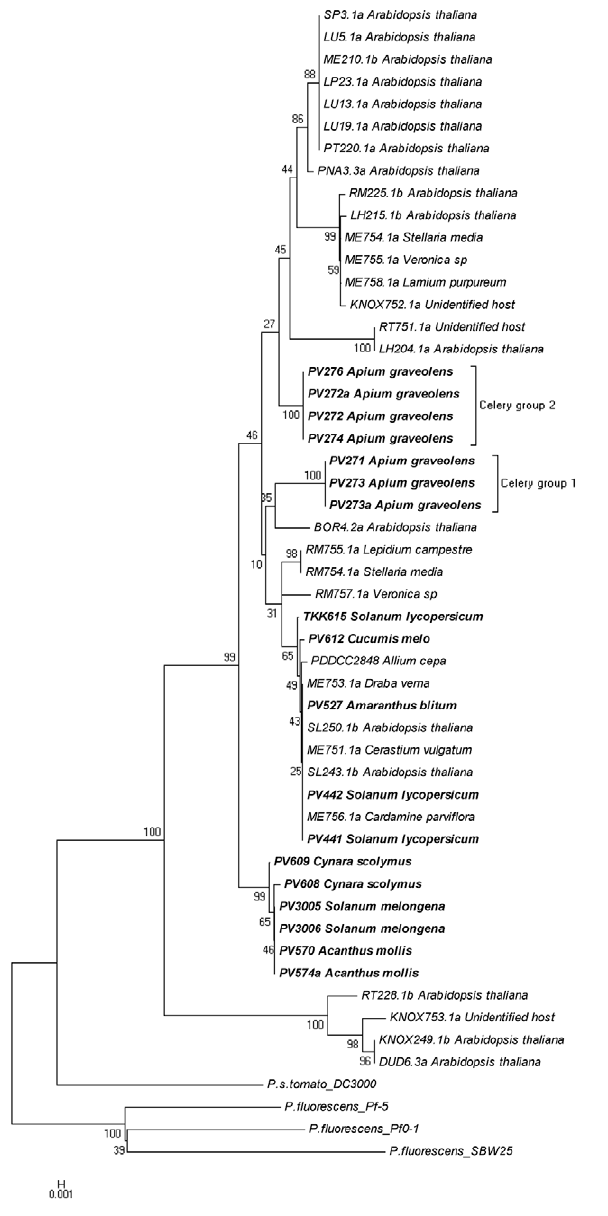
Figure 3. P.viridiflava phylogenetic tree, utilizing gyrB sequenc- es determined in this study along with sequences obtained from GenBank. The evolutionary history was inferred using the Neighbor-Joining method. The bootstrap consensus tree inferred from 1500 replicates is taken to represent the evolutionary history of the taxa analyzed. Branches corresponding to partitions reproduced in less than 50% bootstrap replicates are collapsed. The percentage of replicate trees in which the associated taxa clustered together in the bootstrap test are shown next to the branches. The tree is drawn to scale, with branch lengths in the same units as those of the evolutionary distances used to infer the phylogenetic tree. The evolutionary distances were computed using the Maximum Composite Likelihood method and are in the units of the number of base substitutions per site. The analysis involved 52 nucleotide sequences. All positions containing gaps and missing data were eliminated. There were a total of 740 positions in the final dataset. Evolutionary analyses were conducted in MEGA5. The host plant species is presented next to the code number (e.g. PVXXX) of each isolate.